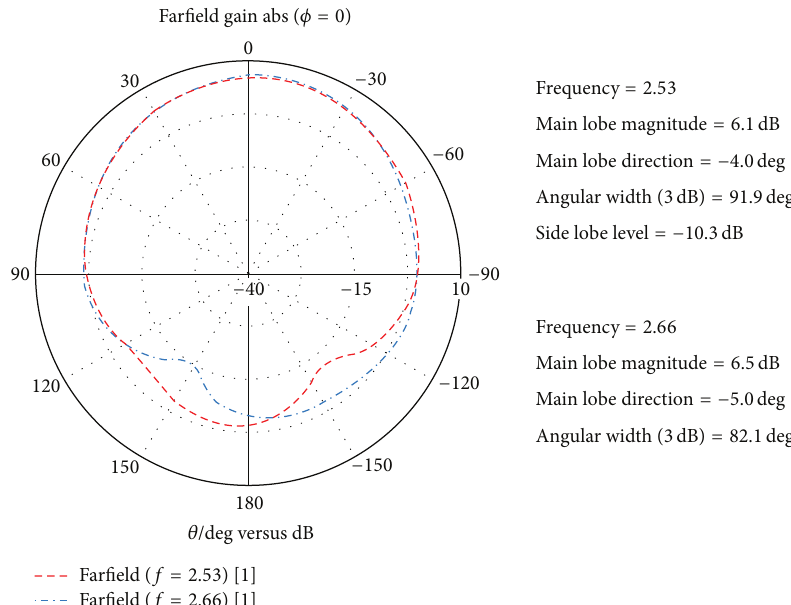
Figure 4: Radiation pattern at 2.53 GHz and 2.66 GHz.